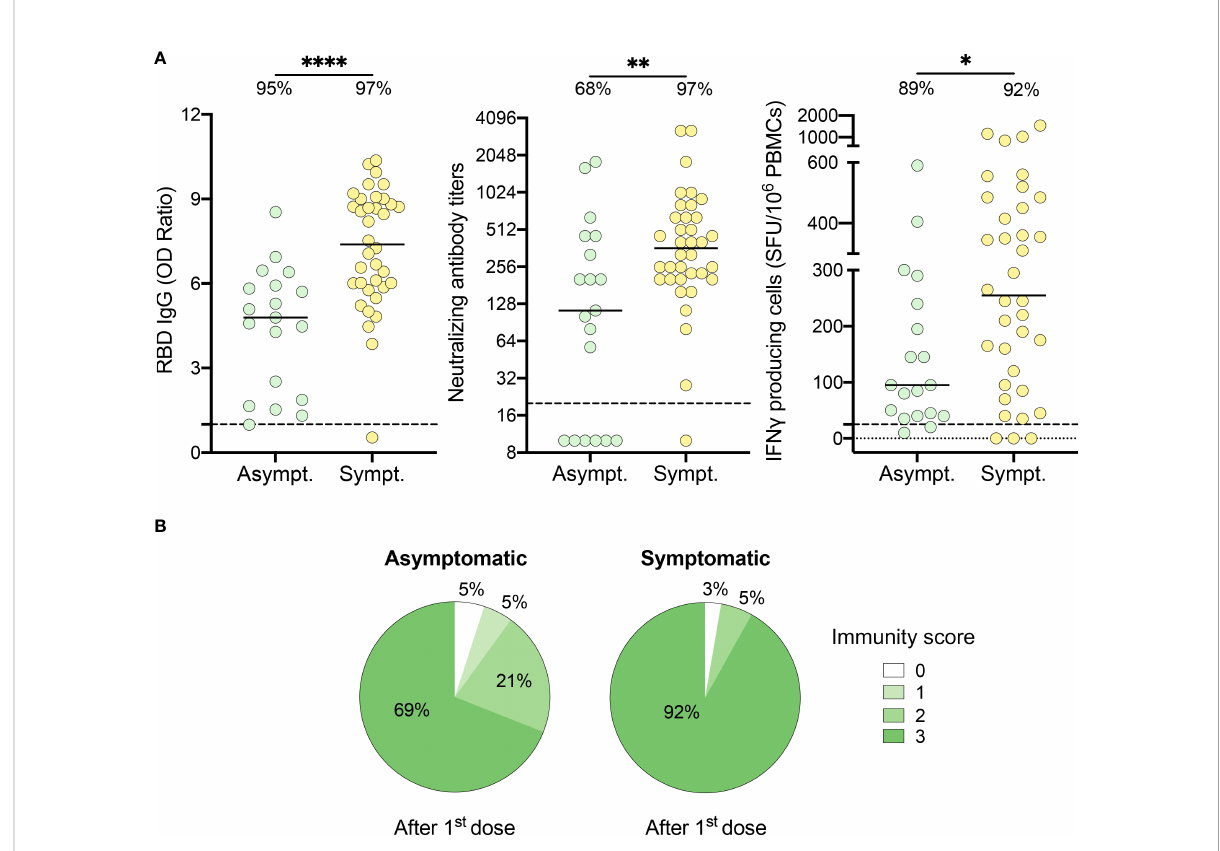
FIGURE 2 HCWs who recovered from an asymptomatic SARS-CoV-2 infection demonstrate partial immune response after one dose of vaccine. (A) SARS- CoV-2 Spike RBD – speci fi c binding IgG levels assessed by ELISA (left panel), SARS-CoV-2 neutralizing antibody titers (middle panel), IFN- g secreting cells per million in response to SARS-CoV-2 Spike glycoprotein peptides (right panel) assessed by ELISpot for asymptomatic (Asympt.) (n=19) and symptomatic (Sympt.) (n=36) recovered HCWs after one dose of vaccine. Dashed black lines indicate the positive threshold value, and the percentage of HCWs with responses above positive threshold value is indicated for each assay. Horizontal bars indicate the median of each group. Statistical signi fi cance was assessed by Mann-Whitney tests. *P <.05; **P <.01; ****P <.0001. (B) Pie charts of calculated immunity score for asymptomatic (left panel) and symptomatic (right panel) recovered HCWs after one dose of